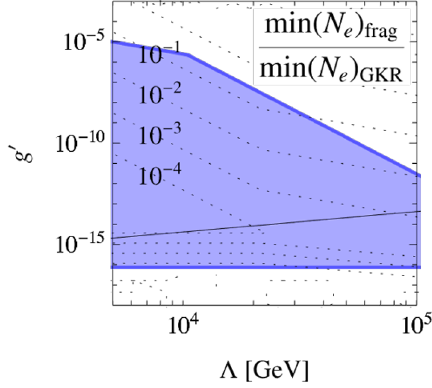
Figure 2 . Same as in figure 3 of the paper. In the scenario where relaxation takes place during an inflation era, ratio of the minimal number of efolds in the “GKR” and “fragmentation” scenarios discussed in section 3.1. The coloured region corresponds to the region where fragmentation can stop the relaxion as an alternative mechanism to Hubble friction like in the GKR scenario. This plot shows that a smaller number if efolds is required to stop with fragmentation. Below the solid line the field excursion Λ /g 0 is